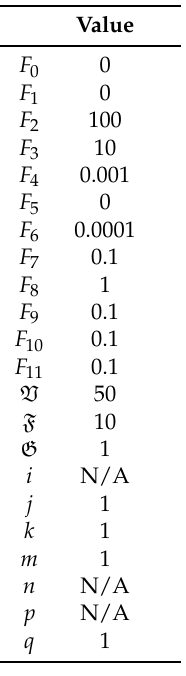
Table 3. Basic parameter set for the sPDE model evaluations. Parameters determining the population dynamics form parameters of Equations (5a)–(5g) and (6a)–(6c). We mention that the choice of i , n , p is free in this case since we have chosen F 0 , F 1 , F 5 = 0 (code not restricted to these parameters).